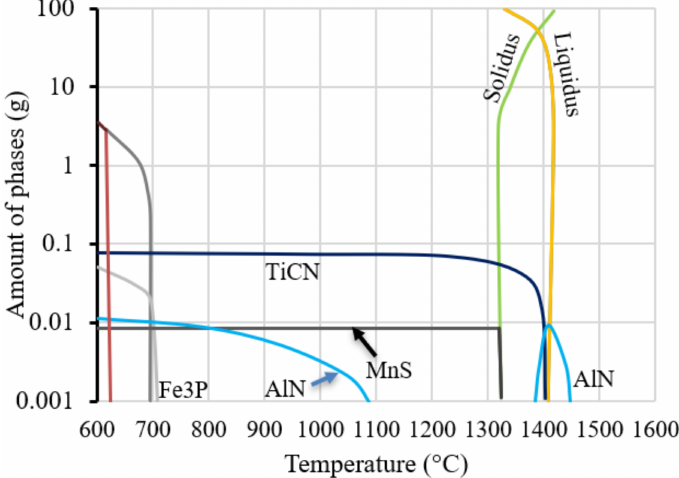
Figure 17. Thermo-Calc precipitation predictions for a TWIP steel with a composition of 0.61% C, 18.0% Mn, 0.003% S, 0.062% Ti, 1.54% Al and 0.007% N. Ti:N ratio of